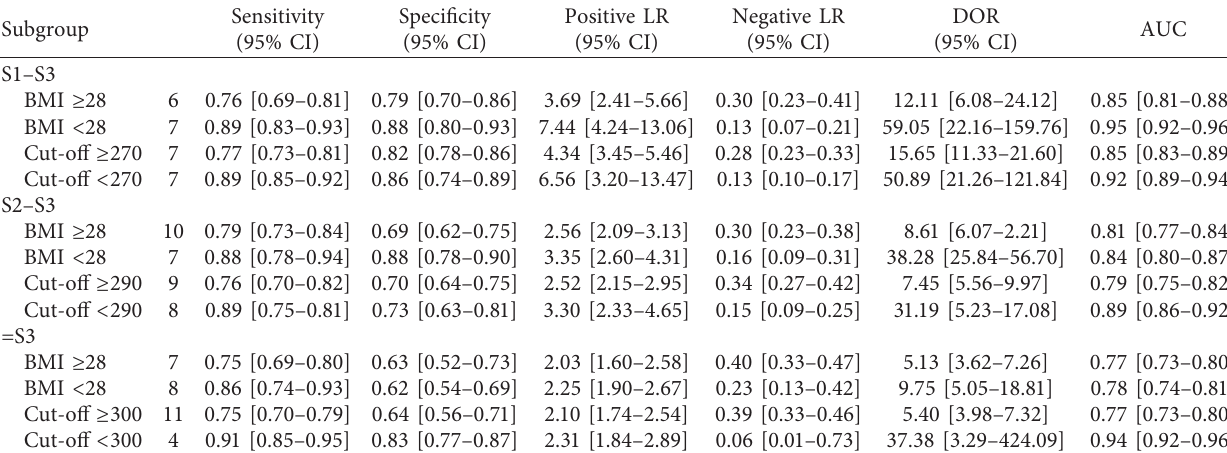
Table 1: Summary diagnostic accuracy parameter estimates and their 95% confidence